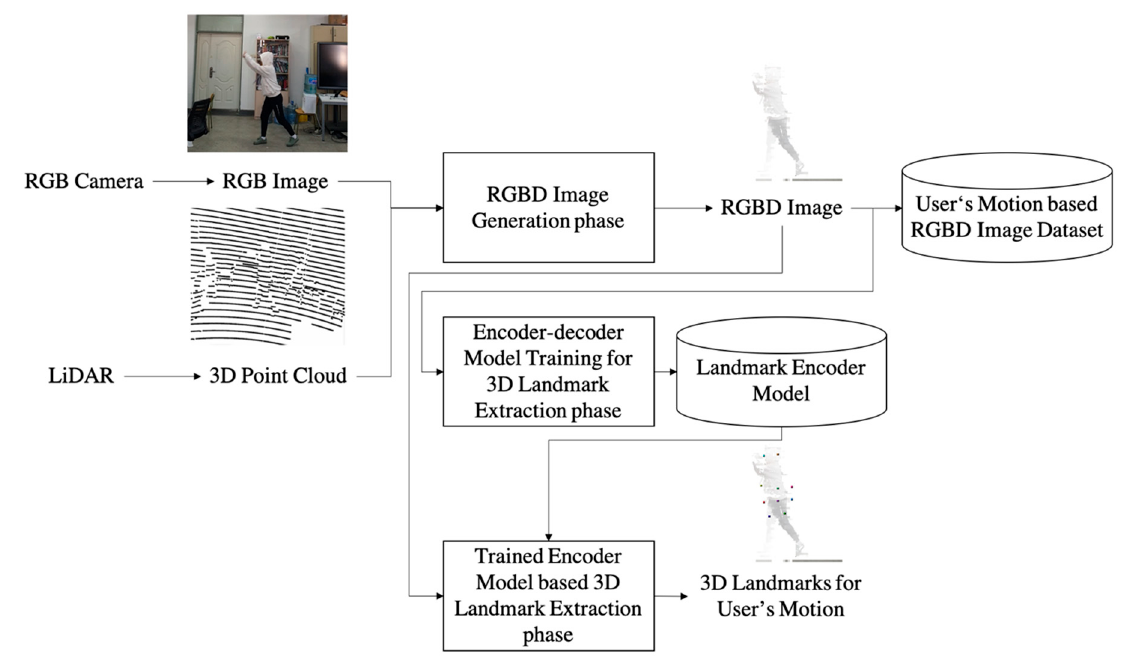
Figure 1. Process of extracting 3D landmarks using a 3D point cloud and an RGB image.